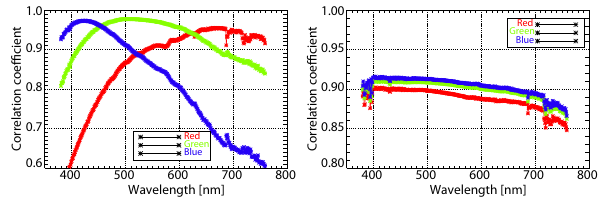
Figure 3. The optimum correlation coefficient ( R 2 ) derived from the comparison with the CCD spectroradiometer and the digital numbers of the three channels of the images from the HSI system for cloudless sky measured on 28 October 2012 (left) and on 23 Oc- tober 2012 for cloudy sky